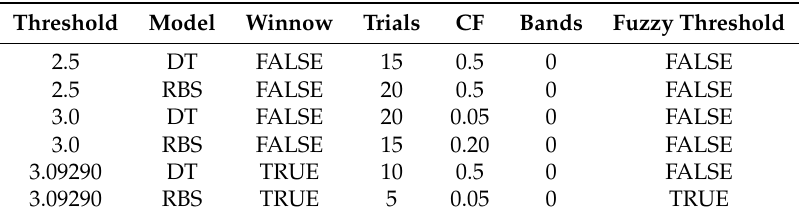
Table 6. Best parameter set found for the Decision Tree (DT) and Rule-Based System (RBS) based on C5.0, for each